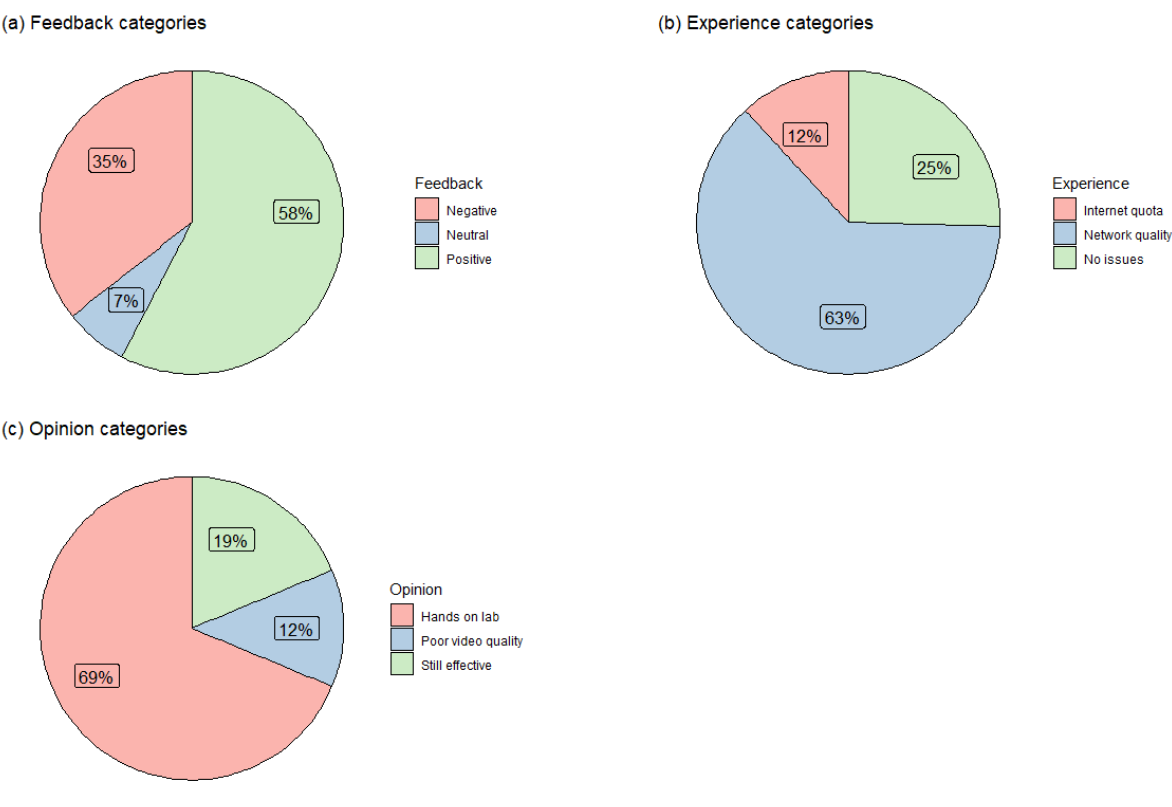
Distribution of Student Feedback, Experience, and